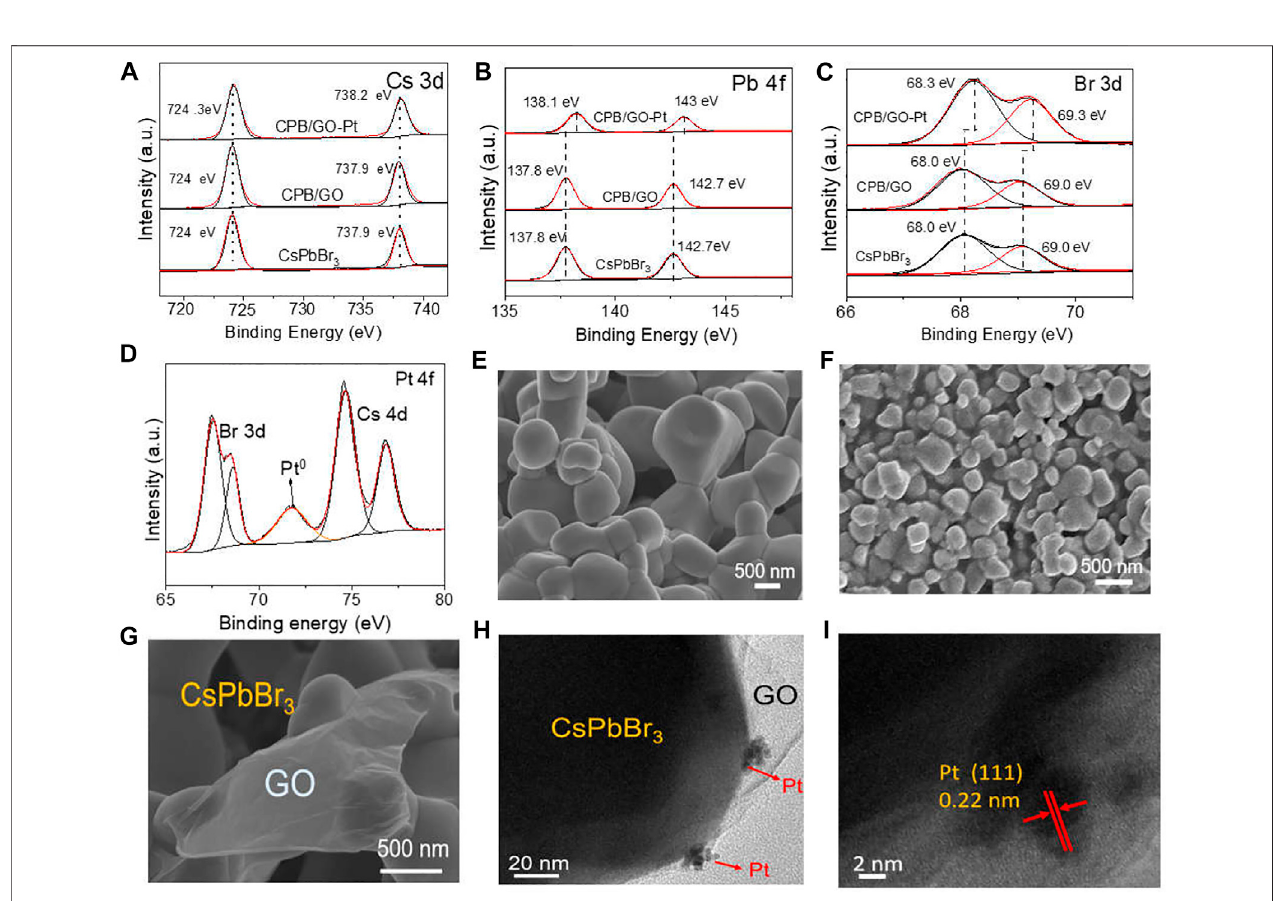
X-ray photoelectron spectroscopy (XPS). High-resolution C 1s peaks of CPB/GO and CPB/GO-Pt samples in Supplementary Figure S4 show a C – O bond at 286.6 eV and C=O bond at 287.7 eV, which can be ascribed to the introduction of GO. Figure 1A shows the Cs 3d spectra of blank CsPbBr 3 , CPB/GO, and CPB/ GO-Pt samples. The double peaks of Cs 3d at 724.1 and 738.1 eV